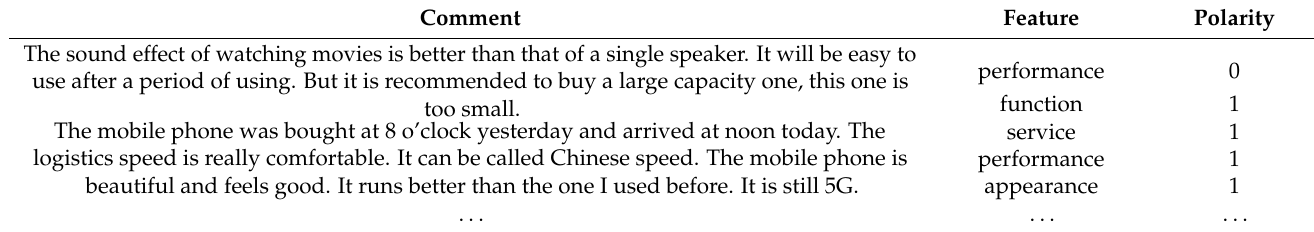
Table 3. Evaluation data labeling table.